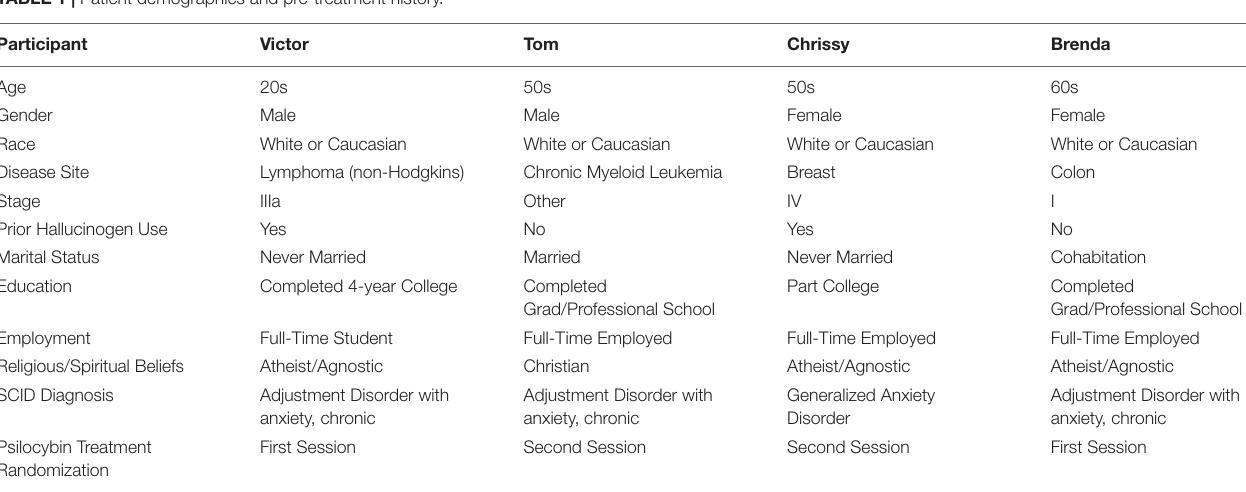
FIGURE 1 | Quantitative data from the four cases presented. Scores on the Hospitalized Anxiety and Depression Scale (HADS), the Beck Depression Inventory (BDI) and the Spielberger State-Trait Anxiety Inventory (STAI) are shown here for each participant over time. TABLE 1 | Patient demographics and pre-treatment